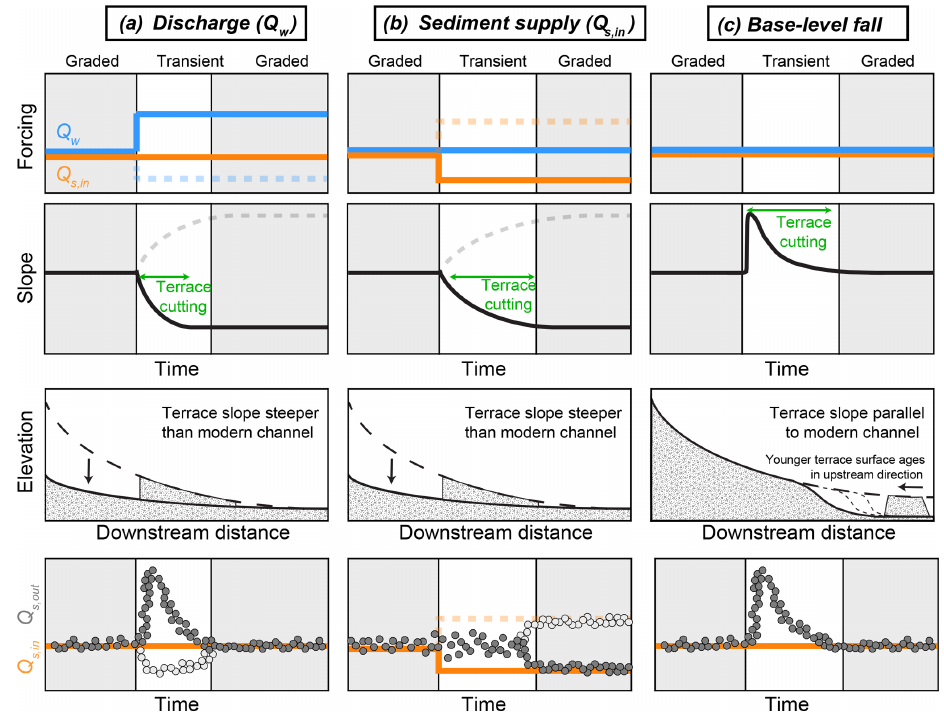
Figure 9. Combining two records of landscape evolution to overcome ambiguity – terraces in the transfer zone and sediment discharge to the deposition zone ( Q s , out ) as a proxy for sedimentation rate. (a) The presence of terraces whose slopes differ from that of the main channel, combined with a simultaneous but transient peak in Q s , out , points towards Q w as the main driver of long-profile evolution. (b) The presence of terraces with steeper slopes compared to the modern channel combined with no immediate peak but an eventual reduction in Q s , out points towards Q s , in as the main driver. (c) A temporary increase in Q s , out combined with terraces that parallel the modern channel profile and become younger in the upstream direction indicates past changes in base